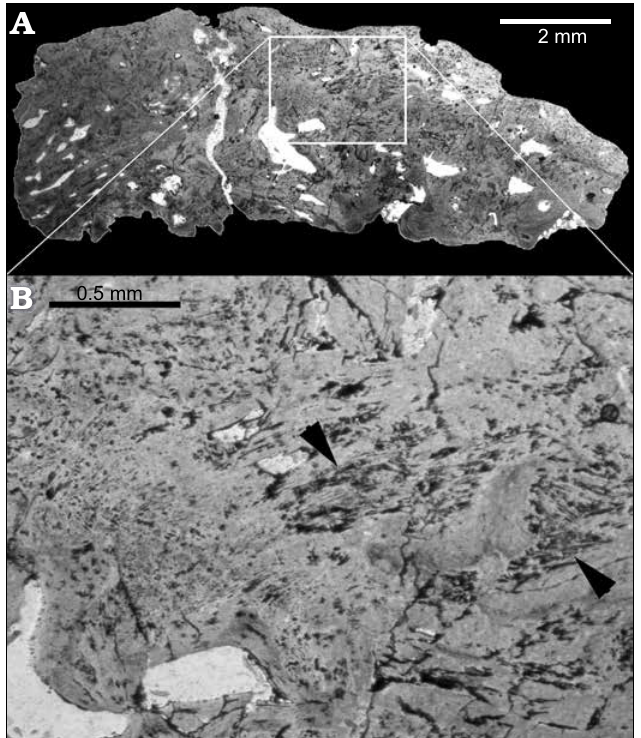
Fig. 5. Thin section of the overgrowth type 1 from the right pedal ungual I of the camarasaurid sauropod SMA 0002 from Upper Jurassic Morrison Formation, Howe-Stephens Quarry, Wyoming, USA ( A ). Detail ( B ), show- ing coarse-grained structure bone in mainly avascular bone